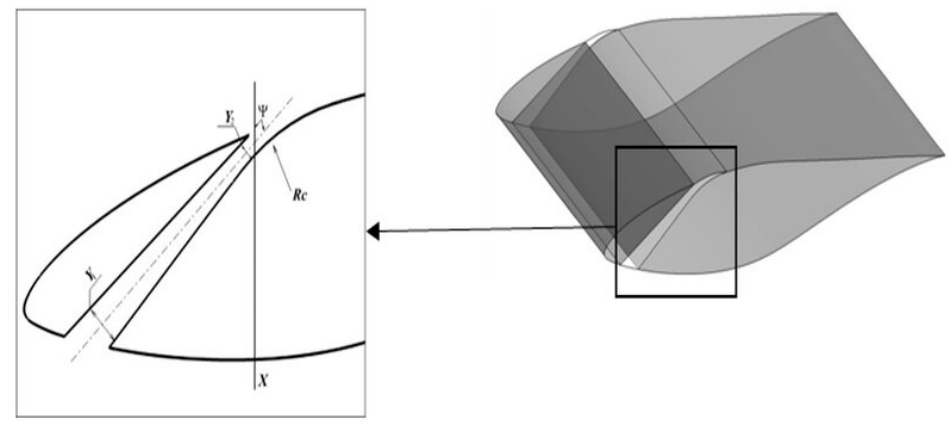
Figure 6. The geometric characteristics of the slot.